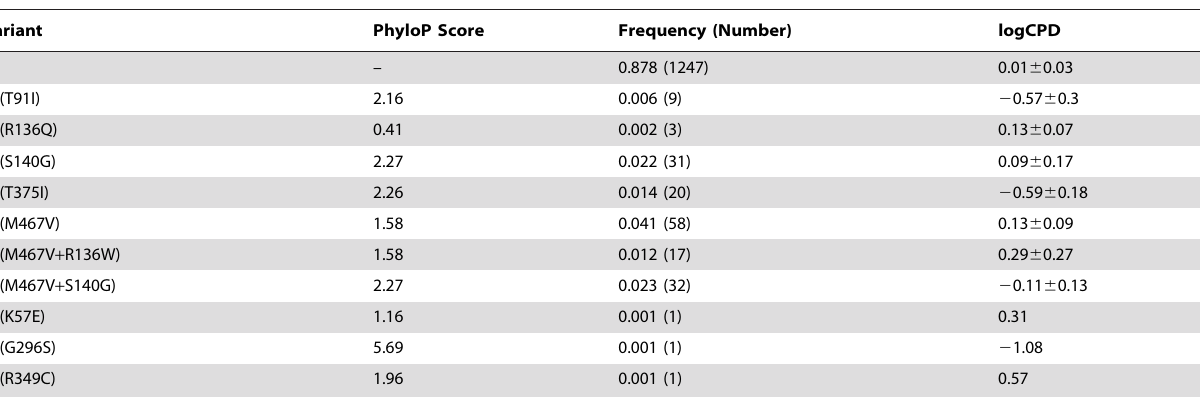
Table 1. CHRNB4 missense variants examined.